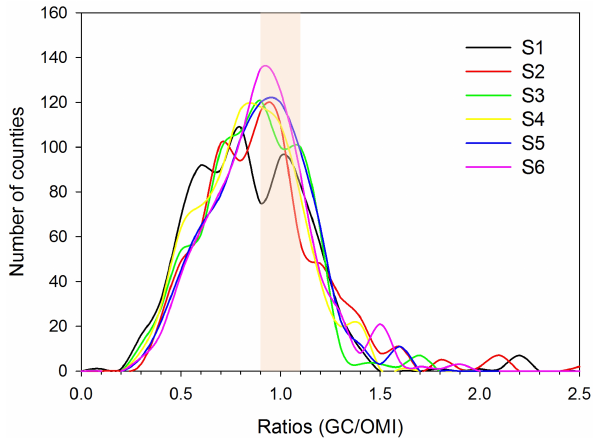
Figure 6. Distributions of the ratios between the county-level model simulations and satellite observations from the six emission inven- tories. The shaded region indicates a range of